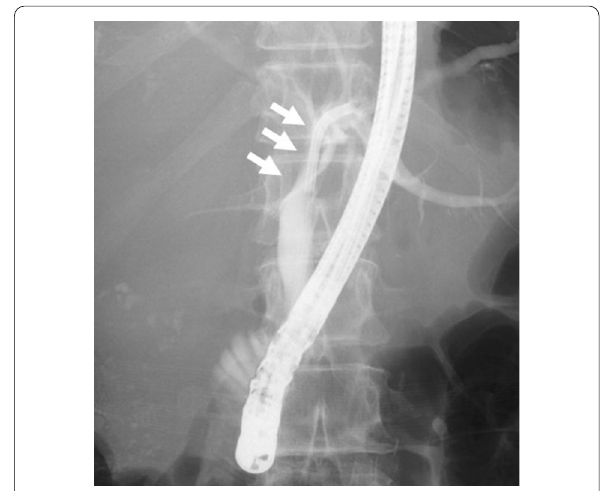
Fig. 2 Endoscopic retrograde cholangiography (ERC) shows compression of the left hepatic duct with